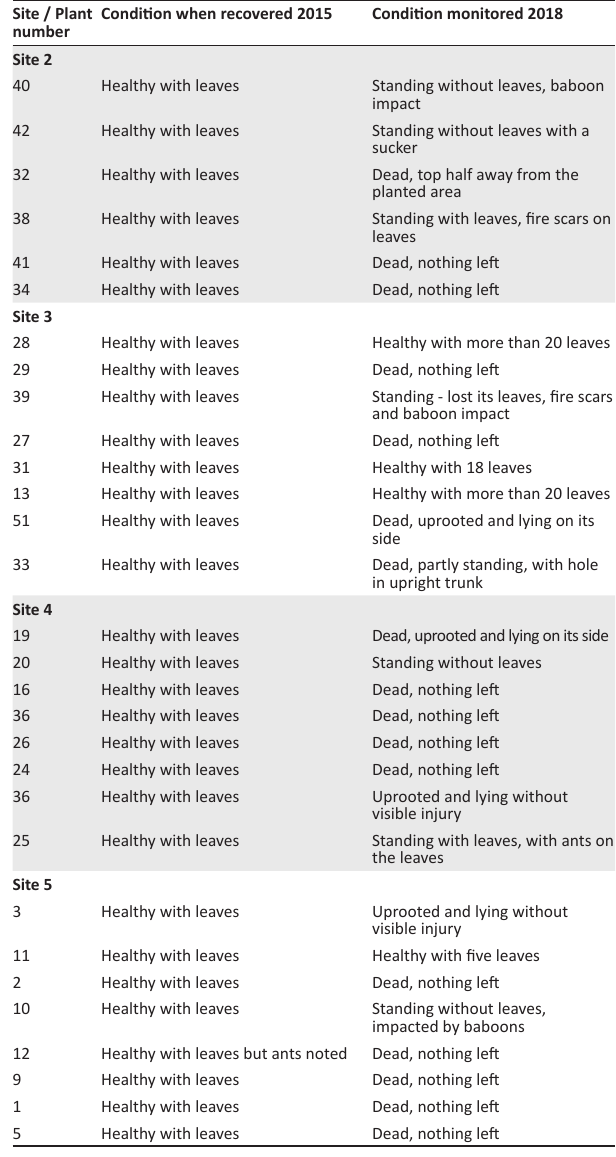
TABLE 3: Monitoring result for replanted cycads in Zuurberg section,